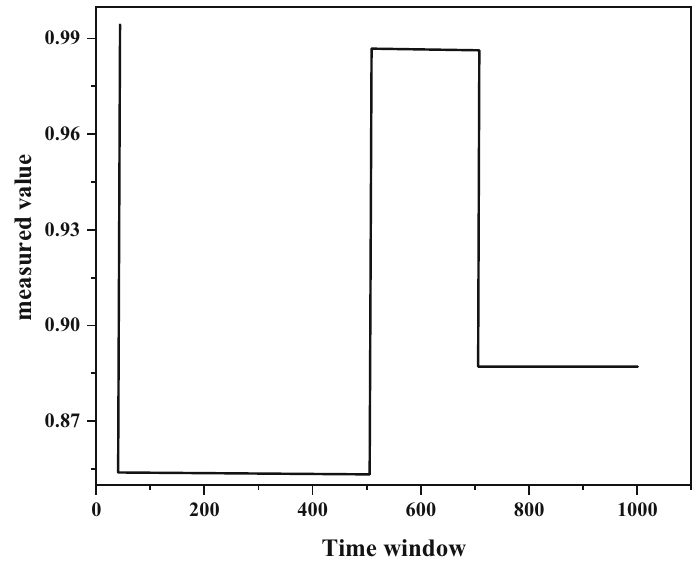
Figure 6: The original data defense changes.